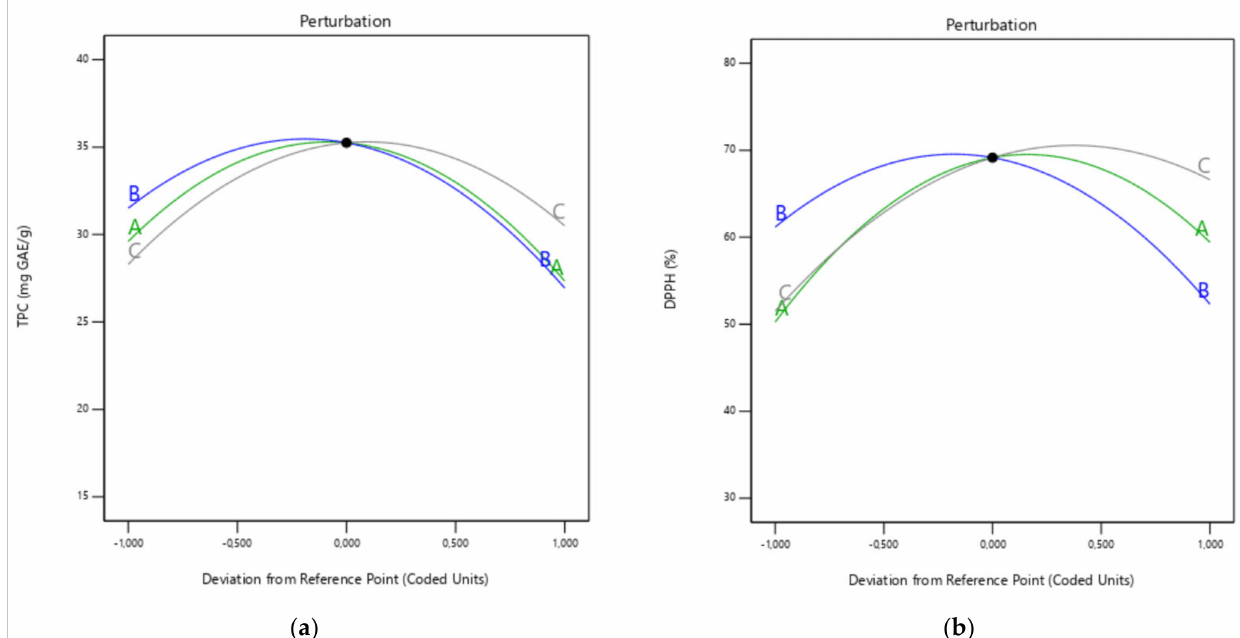
Figure 2. Perturbation plots showing the effect of extraction factors (A: ethanol concentration; B: temperature; C: extraction time) on TPC ( a ) and DPPH radical scavenging activity ( b